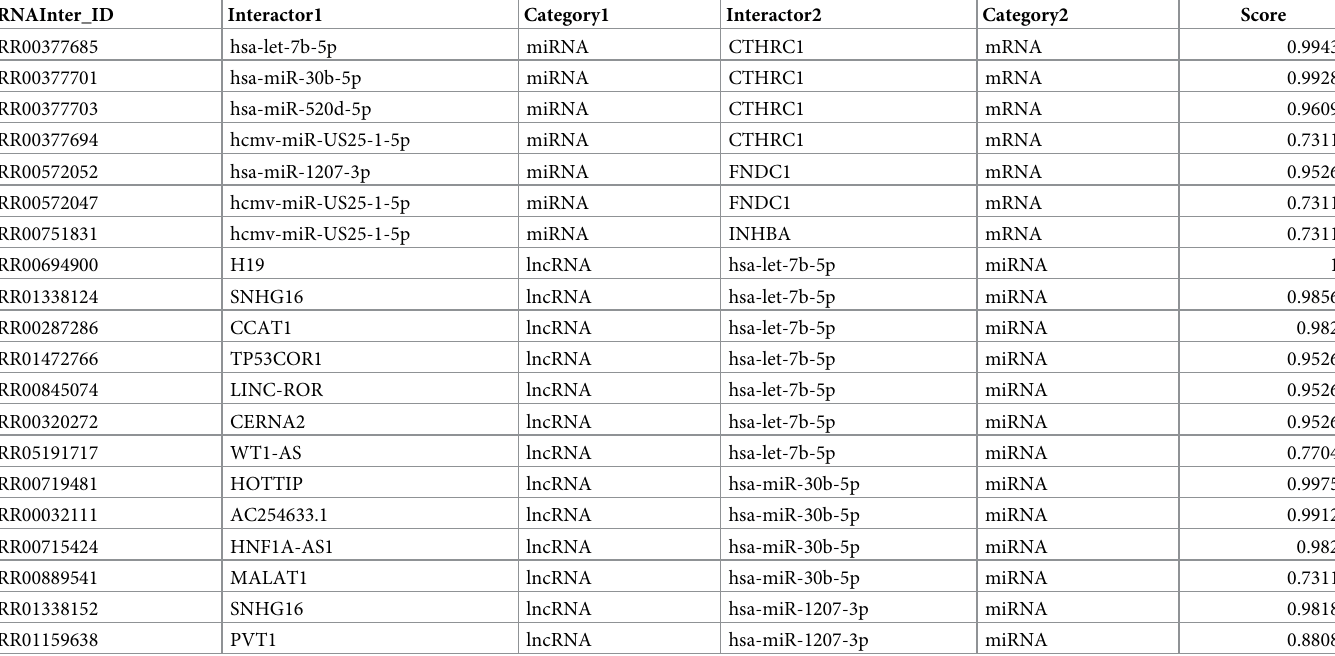
Fig 9. The lncRNA-miRNA-mRNA network was established using the cytoscape software.